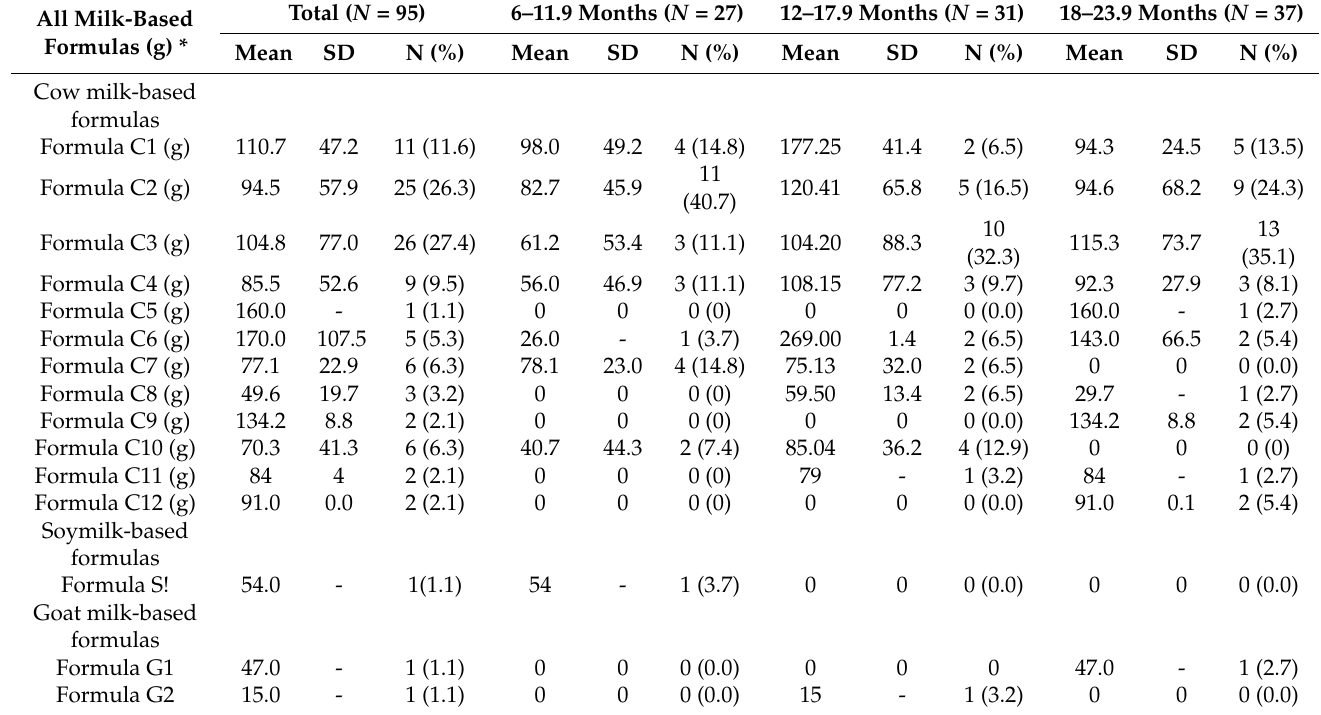
Table 5. Mean intake (g) per day and proportion of infants consuming milk-based formulas by age group ( n =